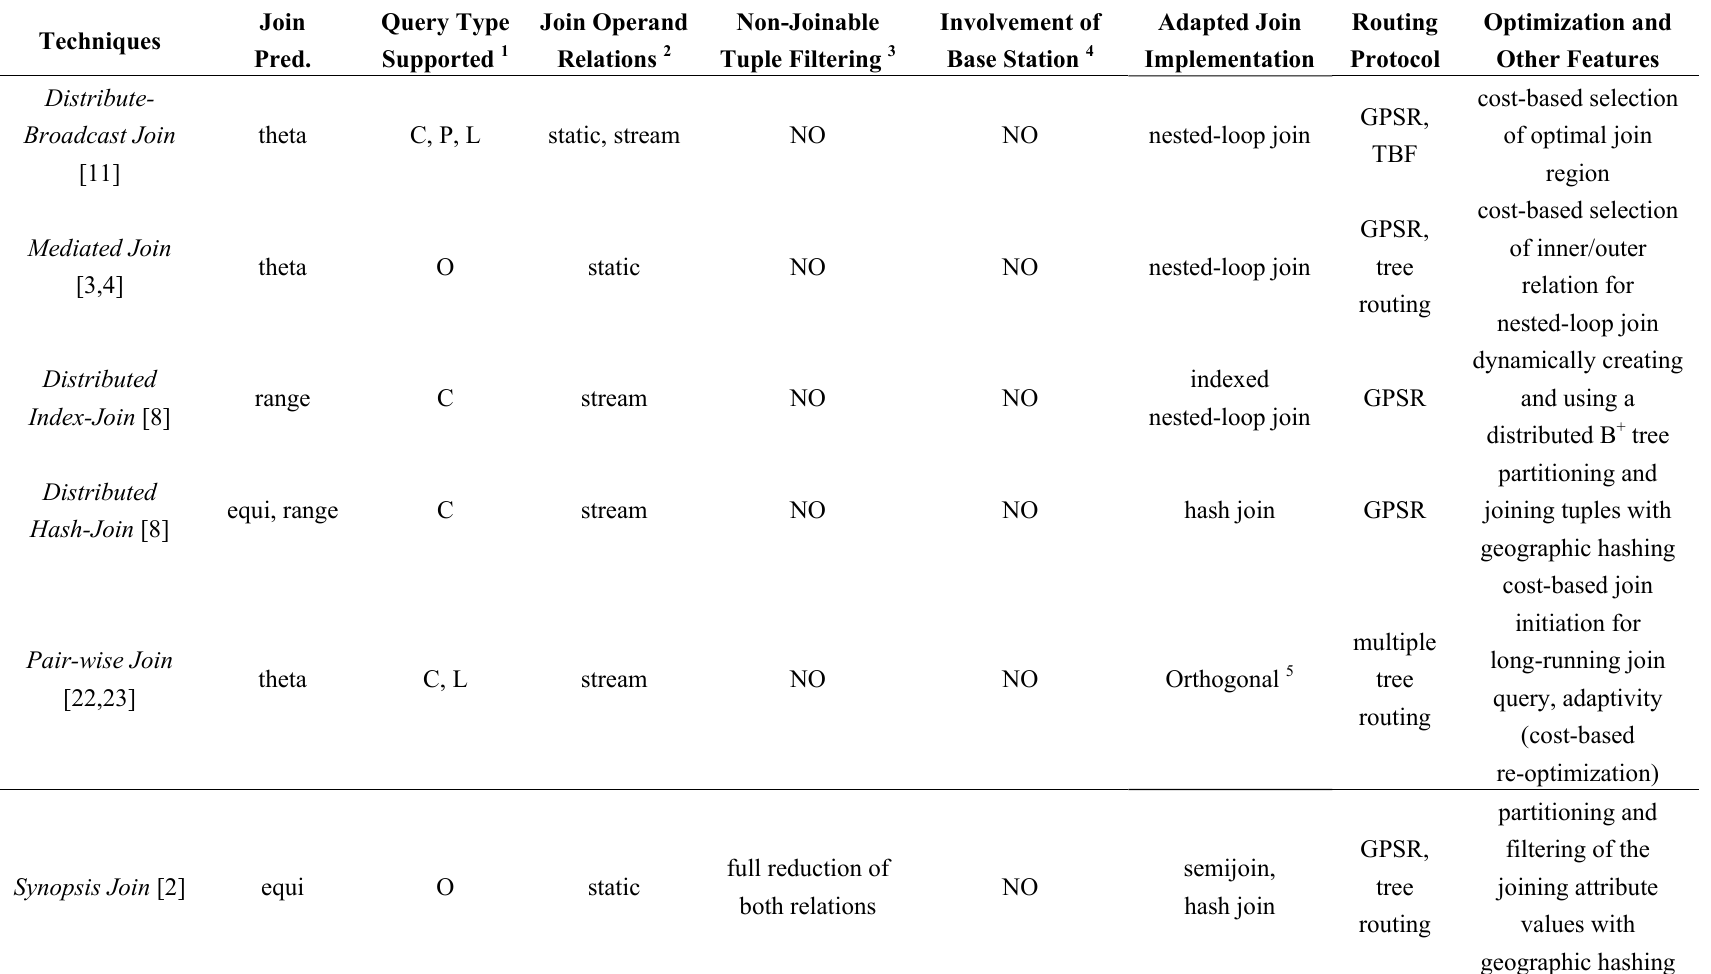
Table 2. Comparison of various in-network join